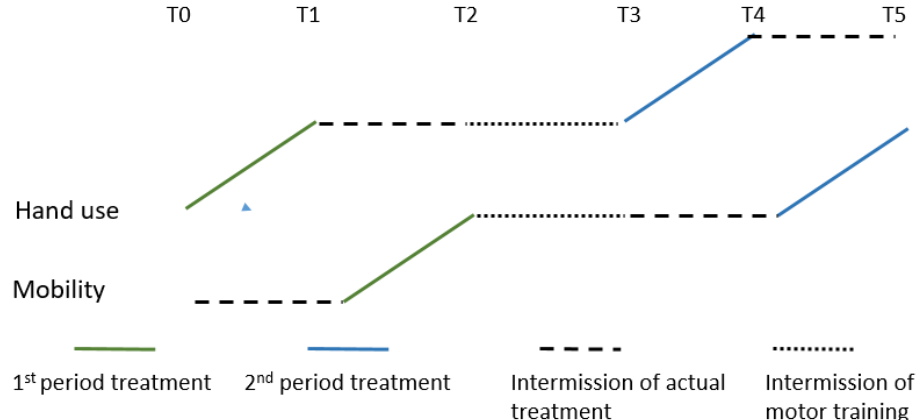
Figure 1. Schematic illustration of the study design. Children were assigned randomly to begin training either their hand use or mobility. This figure is an example that shows when children begin with hand use and thereafter receive mobility training. After these two periods, there is an intermission without motor training. Thereafter, the second block of training starts. T0–T5 comprises the different time points for assessments.